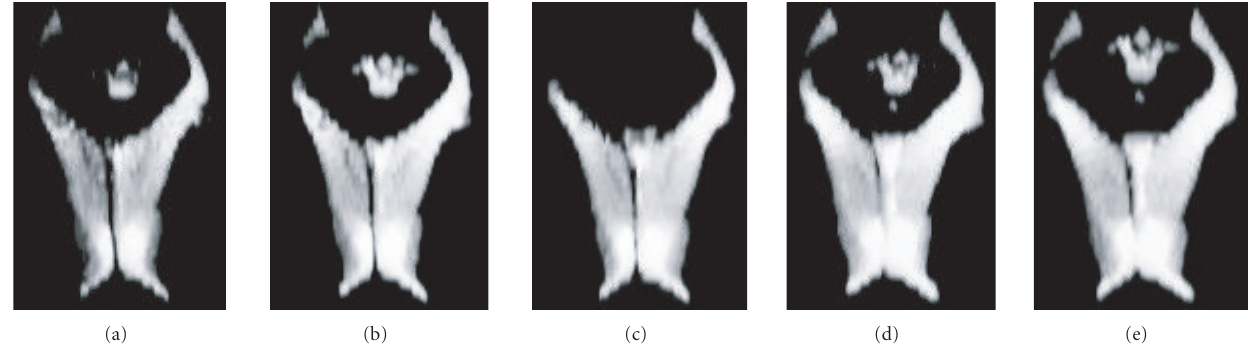
Figure 12: CSF segmentation. Three-dimensional rendering of the ventricles extracted with: (a) IT, (b) M3DLS, (c) FC, (d) HMRF-EM, and (e) manual